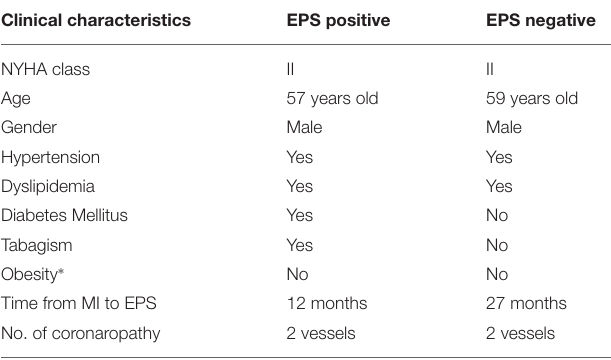
TABLE 1 | Clinical characteristics of the two patients. Clinical characteristics